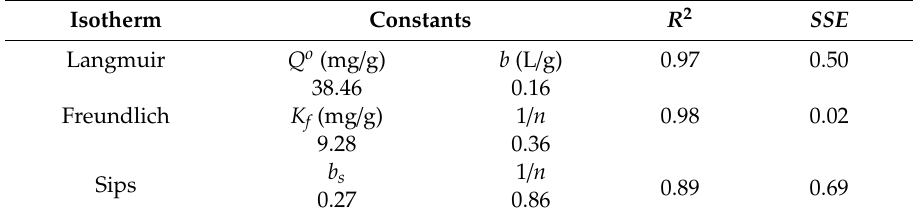
Table 3. Values of Langmuir and Freundlich